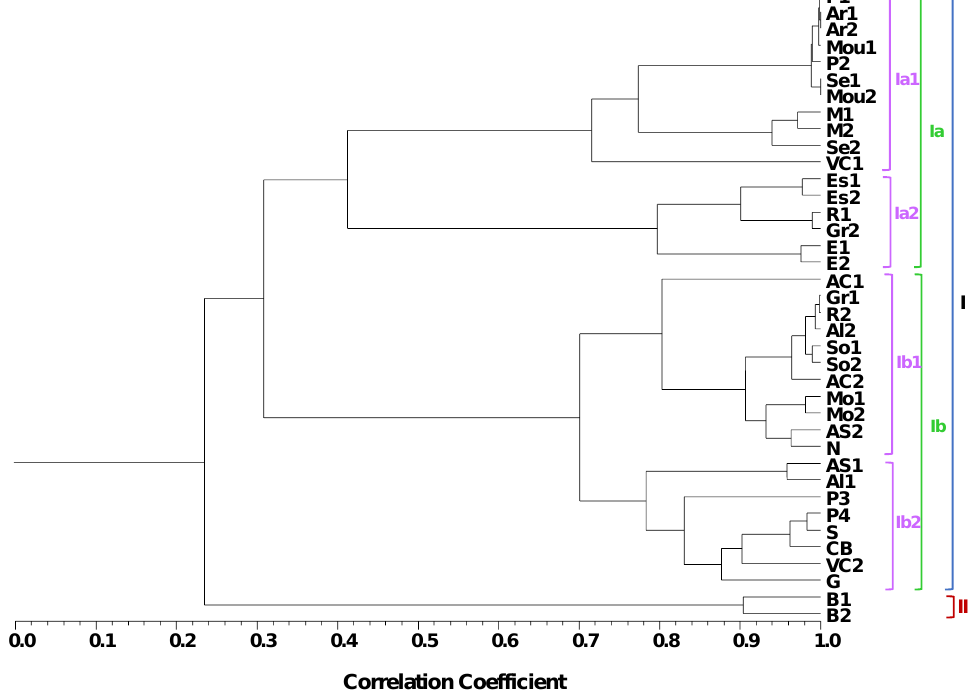
Figure 2. Dendrogram obtained by cluster analysis of the percentage composition of the essential oils isolated by hydrodistillation from the 38 samples, based on correlation, and using the unweighted pair group method with arithmetic average (UPGMA). For harvest site codes, vide Table 1.